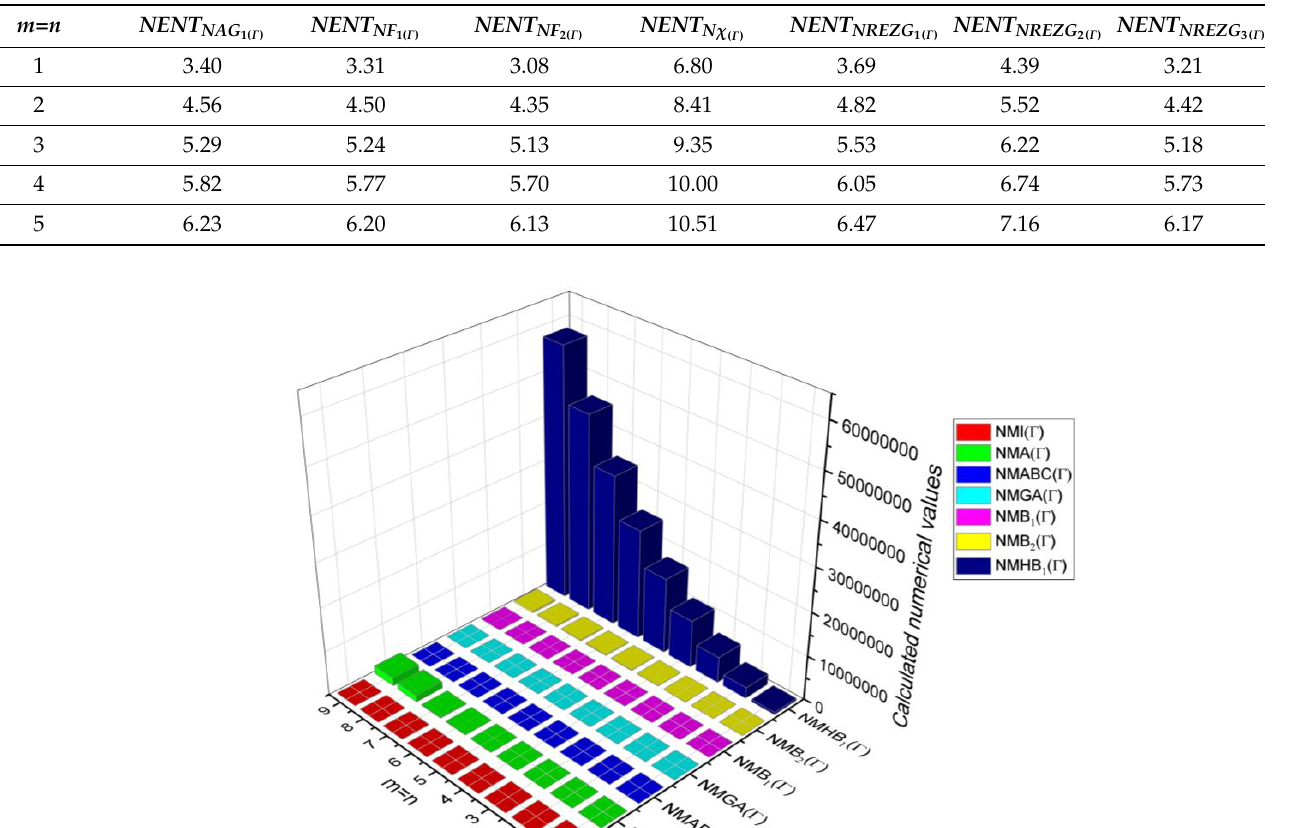
Table 6. Comparison Table for Theorem 3.